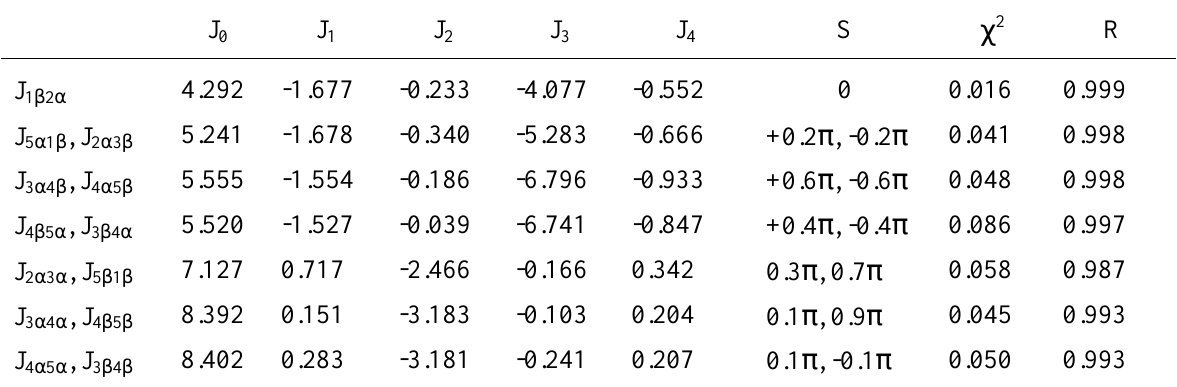
Table 4. Pseudorotation angle dependency parameters for vicinal SSCCs in trans-1,2-dibromocyclo-